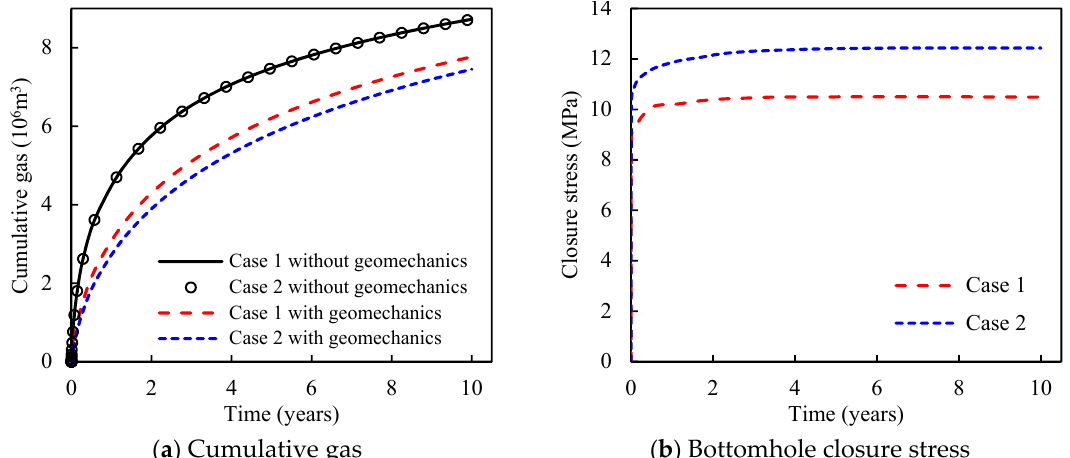
Figure 15. Comparisons of cumulative gas and bottomhole closure stress obtained form Case 1 and Case 2.